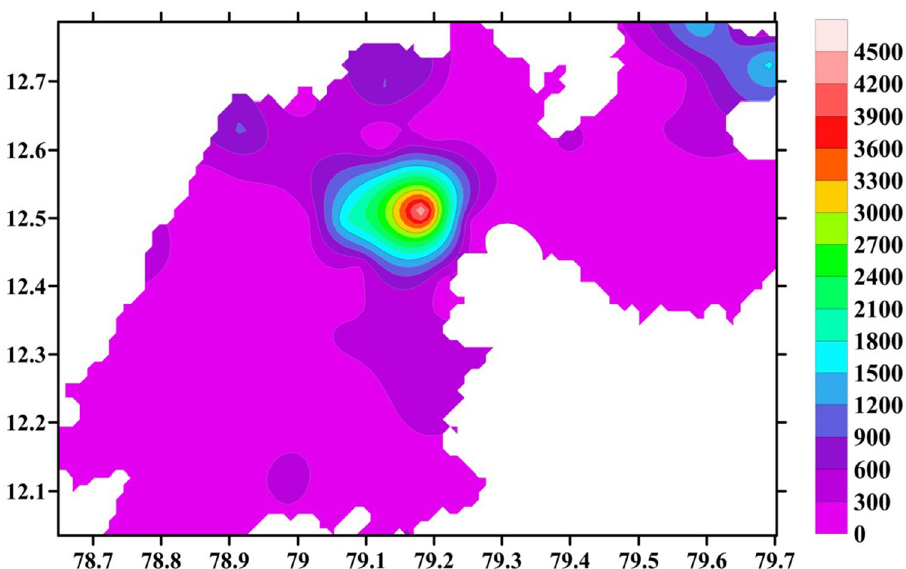
Fig. 24 Spatial variation of cumulative whole body dose in adult